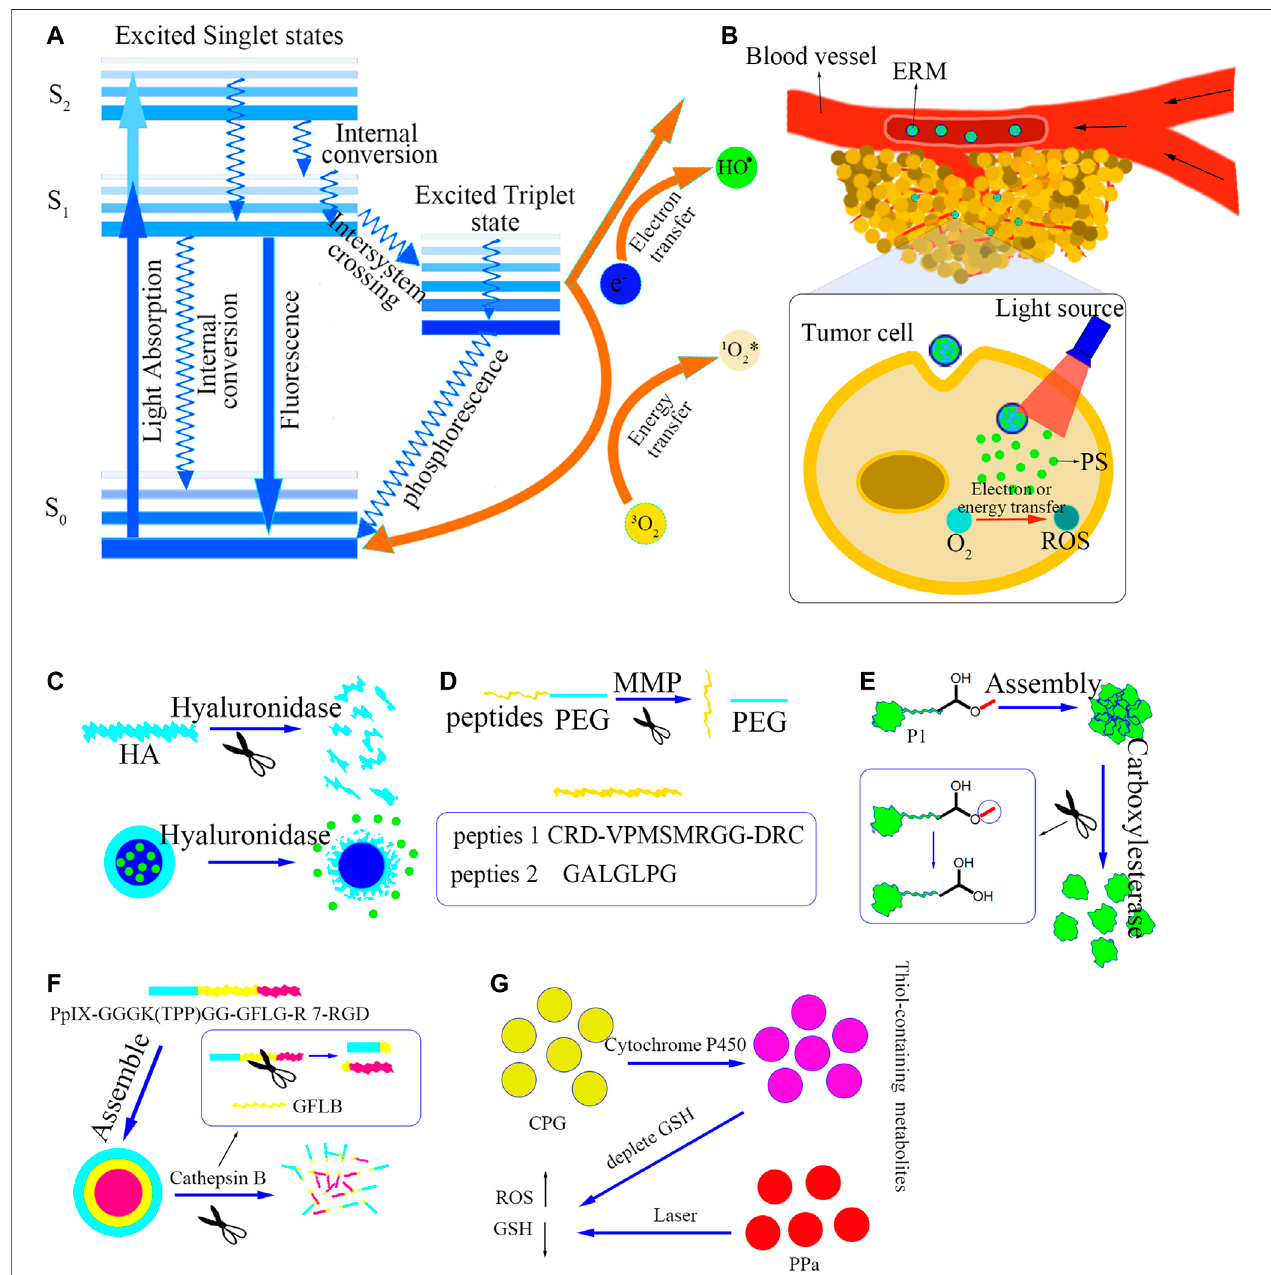
FIGURE 1 | (A) The principle of ROS generated by photosensitizer excitation. (B) The process of ERM delivering PS. (C-G) The response principles of the fi ve ERMs, followed by hyaluronidase-responsive, Matrix metalloproteinase-responsive, Carboxylesterase-responsive, Cathepsin B-responsive and Cytochrome P450-